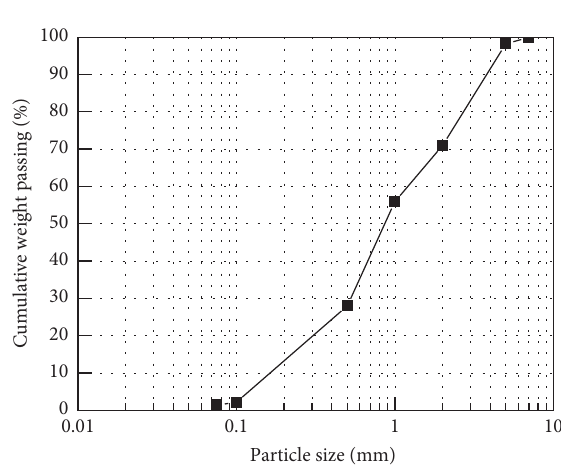
Figure 4: Particle size distribution